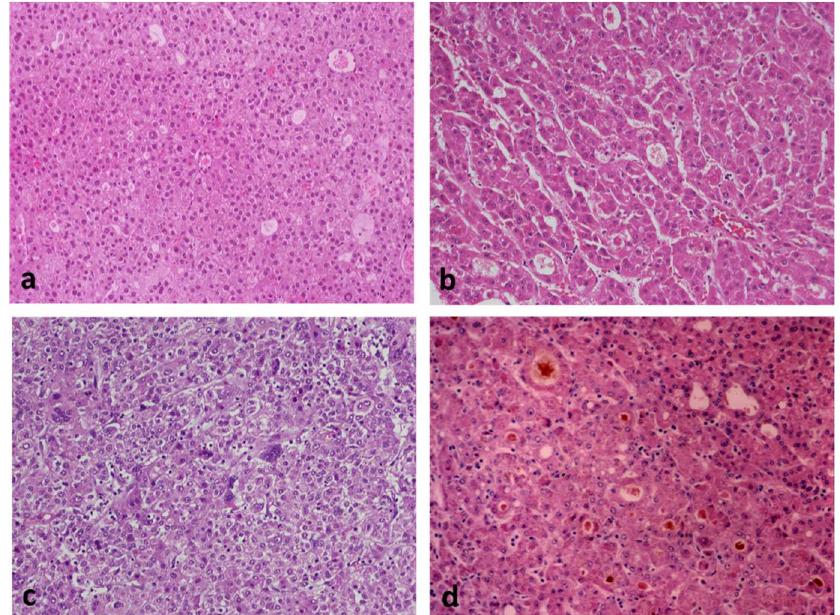
Figure 3. Degrees of differentiation in HCC: ( a ) This well-differentiated HCC consists of neoplastic cells resembling hepatocytes, which are arranged in trabeculae and pseudoglandular structures. ( b ) As compared to ( a ), this moderately differentiated HCC displays an increased nuclear–cytoplasmic ratio, larger nuclei with prominent nucleoli, and increased cytoplasmic basophilia. ( c ) This poorly differentiated HCC is characterized by marked tumor cell pleomorphism, including multinucleated cells; the architecture is trabecular and compact. ( d ) Bile production by neoplastic cells, often in pseudoglandular structures, as illustrated here, is a diagnostic feature of HCC.